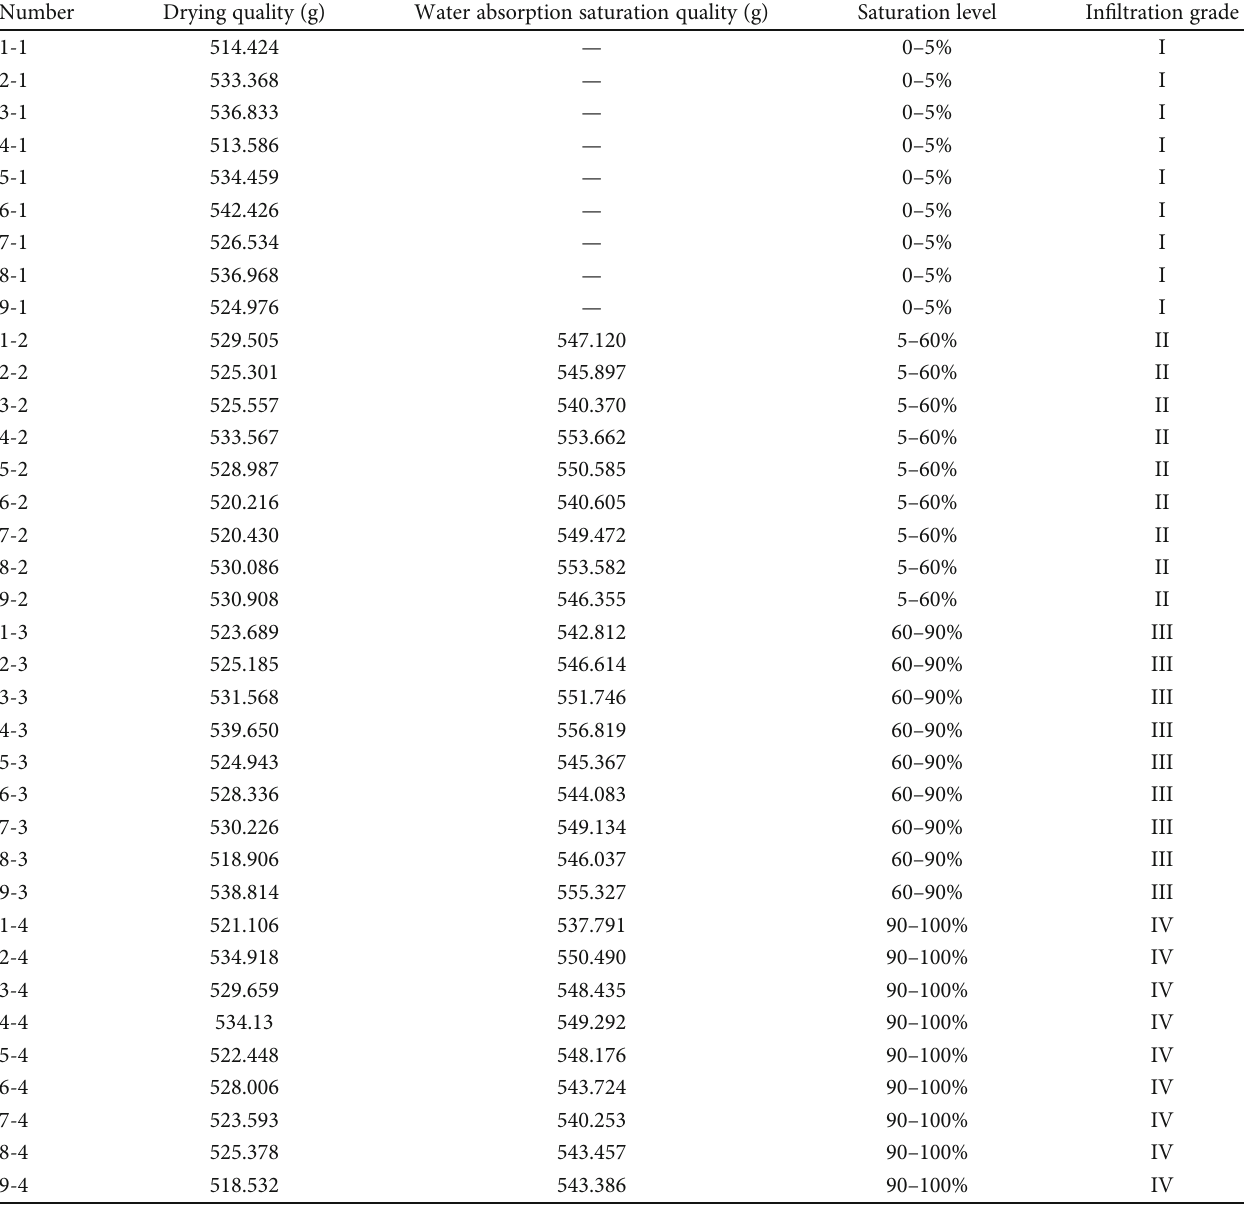
Table 2: Basic parameters of the test